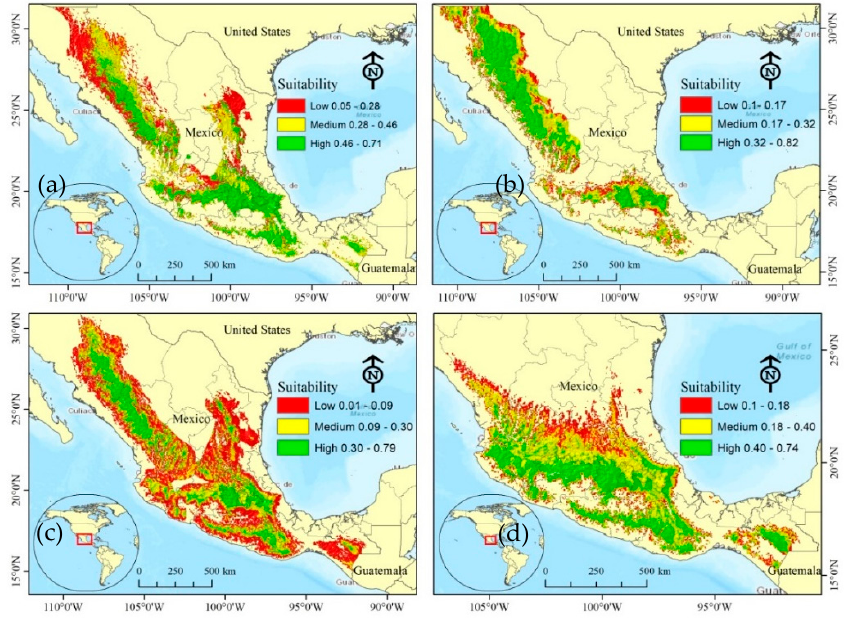
Figure 3. Climate suitability for: ( a ) Dendroctonus mexicanus , ( b ) Pinus leiophylla , ( c ) Pinus teocote , and ( d ) Pinus devoniana , stratified in medium, high and low, according to the minimum and maximum intra-stratum variance among them, solved by using a dynamic programming technique. Table 3. Relative contribution (in percentage) of the suitability model bioclimatic variables of each species determined by the jackknife test and the detailed bioclimatic profile of the species. Variable